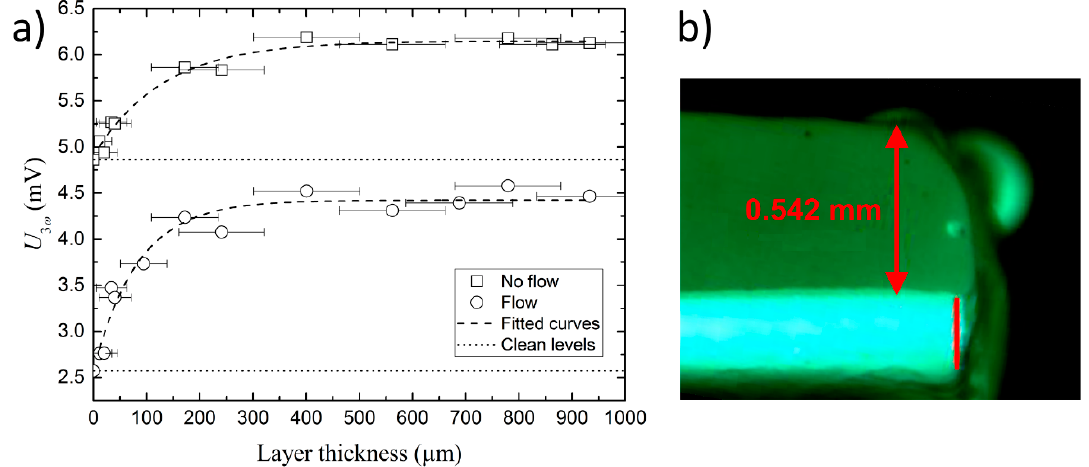
Figure 8. ( a ) U 3 ω as a function of biofilm layer thickness. The data follows a reverse exponential decay function within the measured range, as shown with the dashed lines. The dotted lines show the signal levels for the clean sensor; ( b ) Microscope side view image of the sensor with a layer of wax.